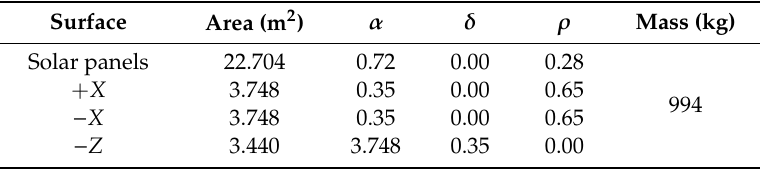
Table 4. Initial optical properties and areas of the BeiDou-2